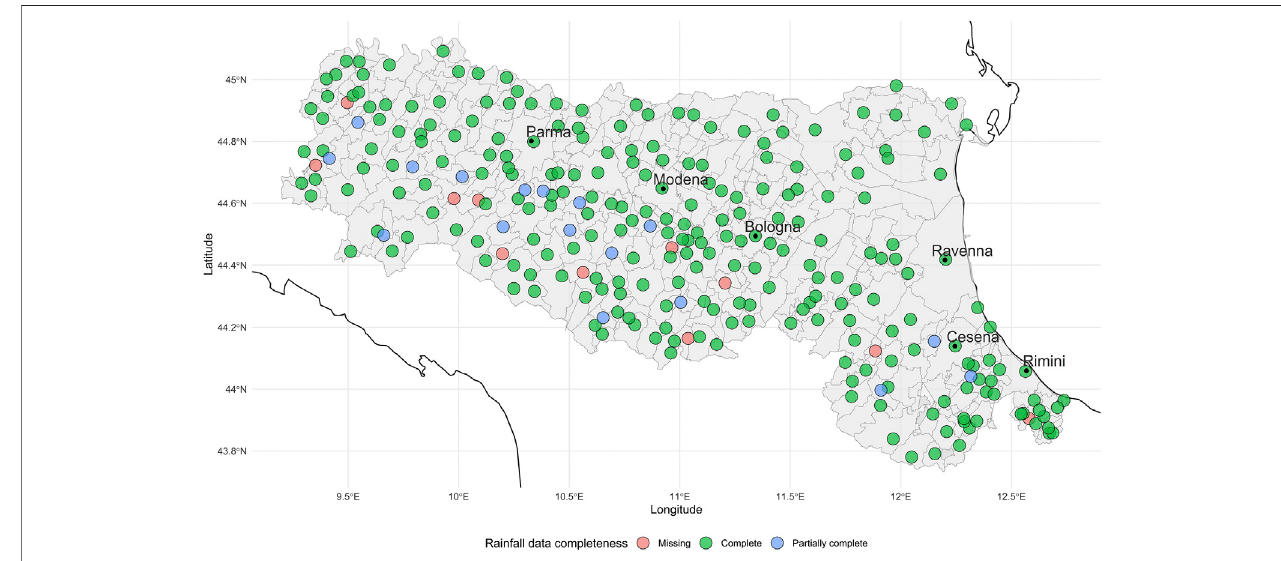
FIGURE 2 | Completeness of rainfall records by municipality.